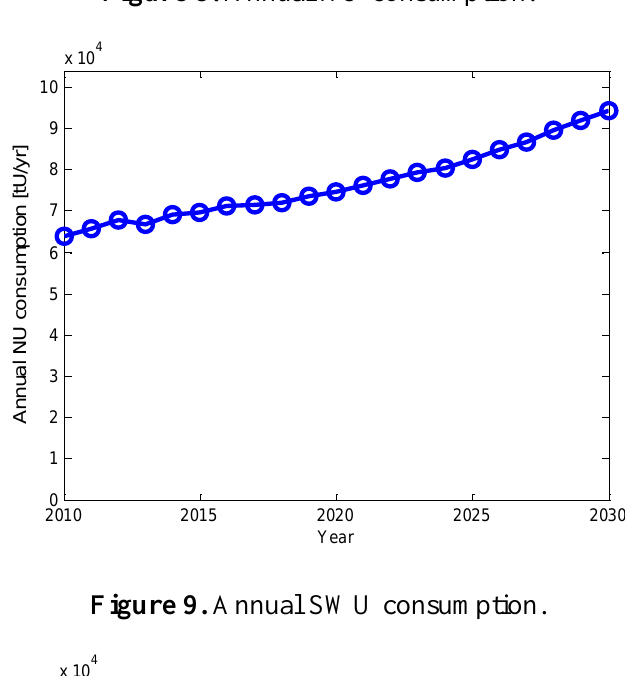
Figure 8. Annual NU consumption.